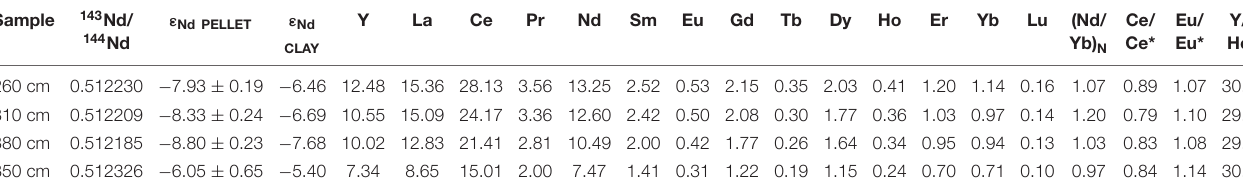
TABLE 5 | Rare earth element and Nd isotopic composition of fecal pellet separates (core MD03-2607). Sample 143 Nd/ ε Nd PELLET ε Nd Y La Ce Pr Nd Sm Eu Gd Tb Dy Ho Er Yb Lu (Nd/ Ce/ Eu/ Y/ 144 Nd